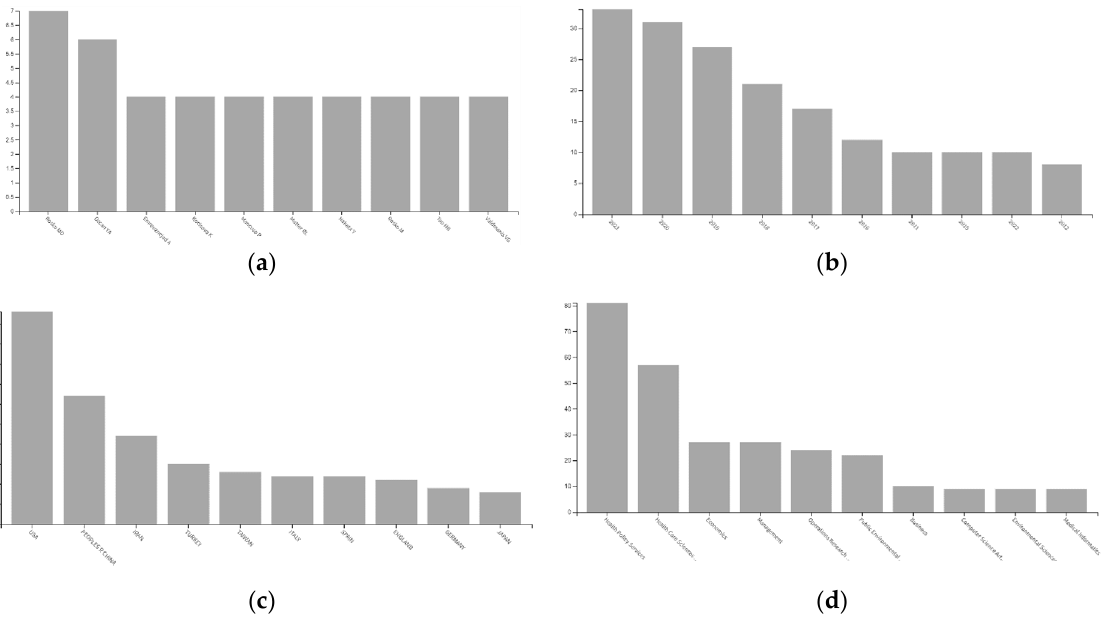
Figure 1. Results sorted by authors, year, country and field. Panels a , b , c and d , illustrate the docu- ment distribution with bar charts per author (panel a ), year (panel b ), geographic region (panel c ) and Web of Science categories (panel d ).